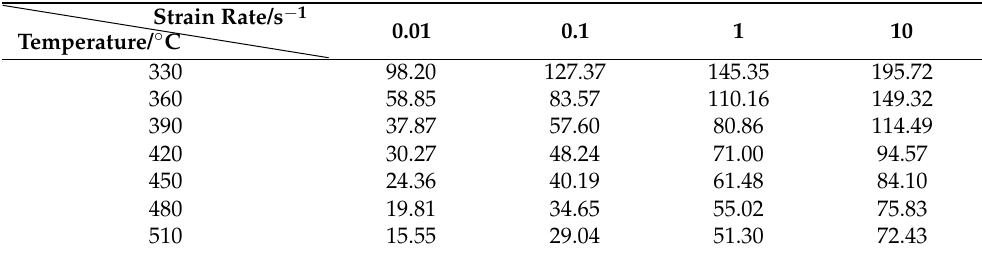
Table 2. Characteristic stresses under different deformation conditions